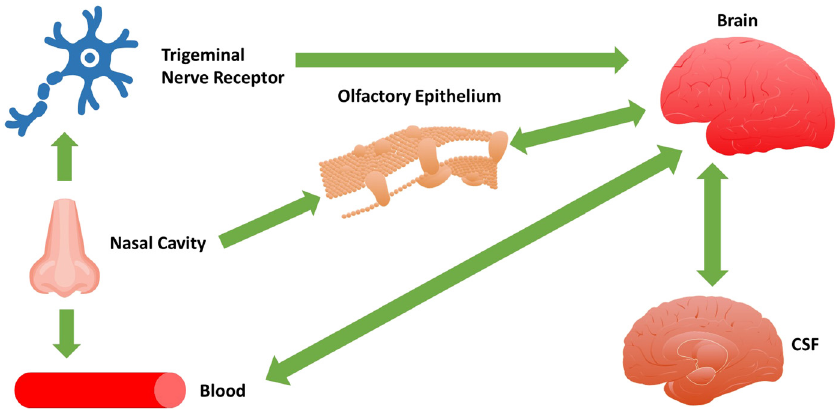
Figure 8: Drug delivery to CNS by olfactory